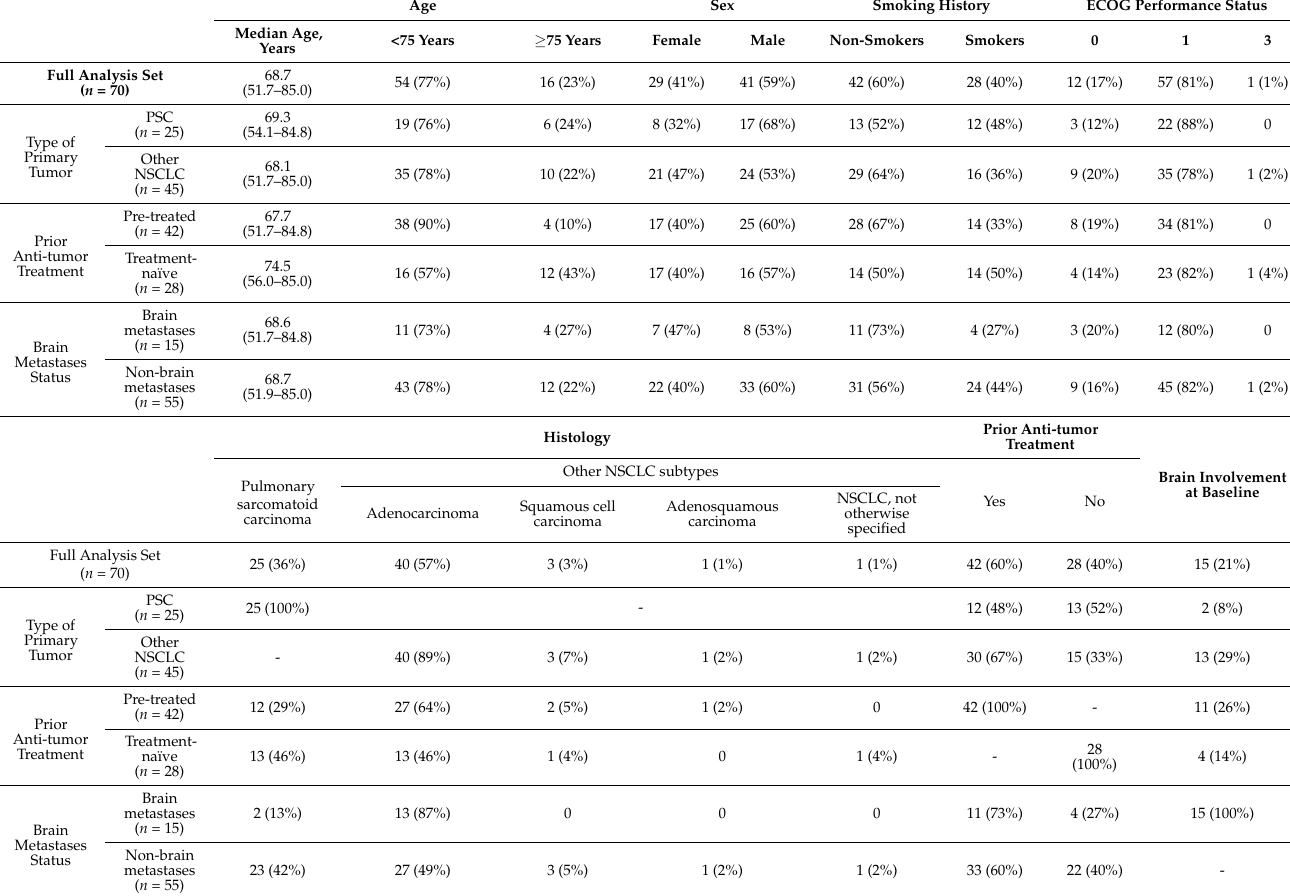
Table 2. Baseline characteristics of phase II trial conducted in China [48]. Age Sex SmokingHistory